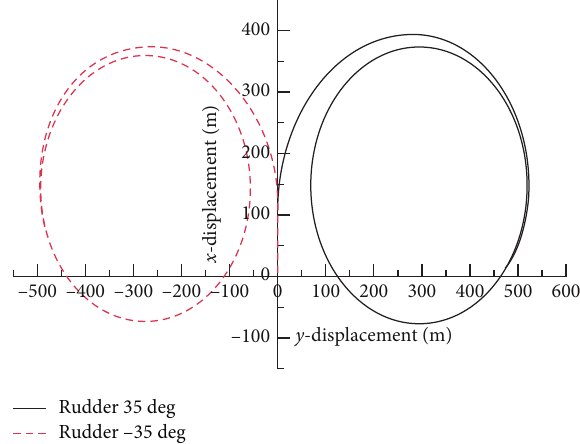
Figure 7: Rotation trajectory for a rudder angle of approximately 35 ° (main engine speed of